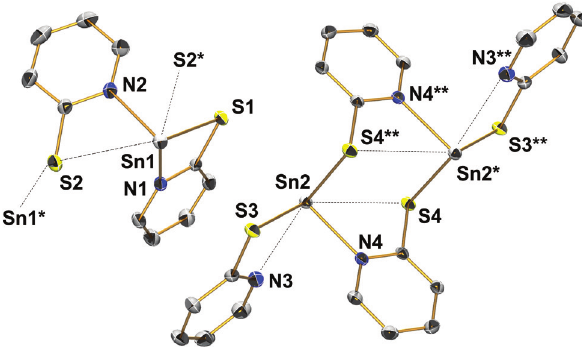
in the crystal structure. 2 moieties. 2